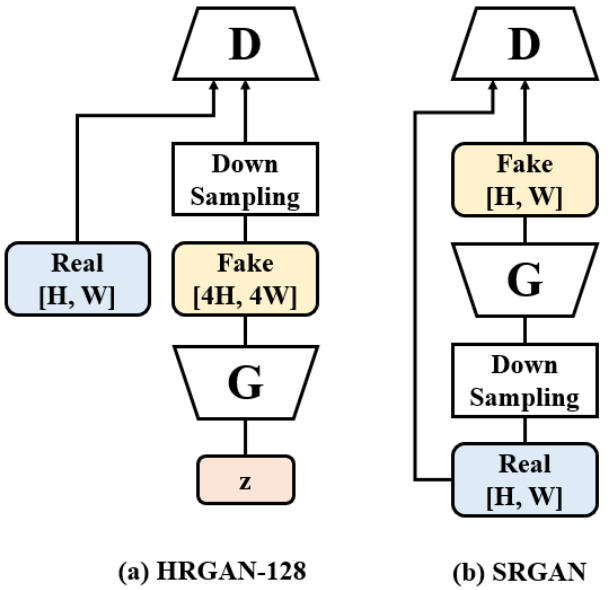
Figure 2. The comparison of the architectures of ( a ) HRGAN and ( b ) SRGAN. When the models are trained with the CIFAR-10 dataset, H and W become 32, signifying that the maximum resolution of generated images in SRGAN is 32 × 32 while HRGAN can produce 64 × 64 and 128 × 128 resolutions of images.